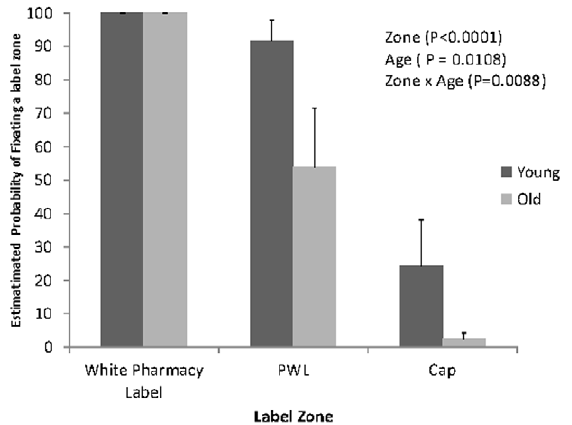
Figure 2. Least Square Mean Estimates (across subjects) of percentage of the probability of fixation by zone and age group. Error bars represent the between subjects standard error.